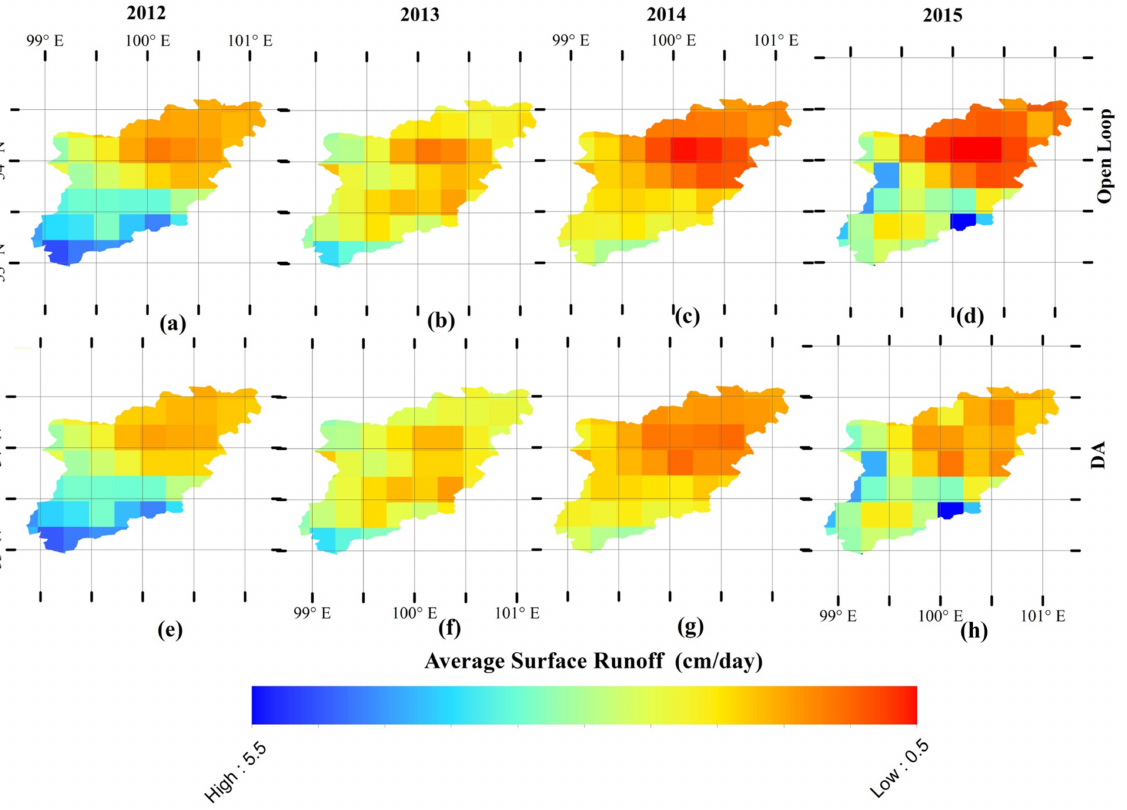
Figure 9. Represents spatial pattern of surface runoff over Iya Basin. Annual mean from open loop are shown in top row ( a – d ), from DA in bottom row ( e – h